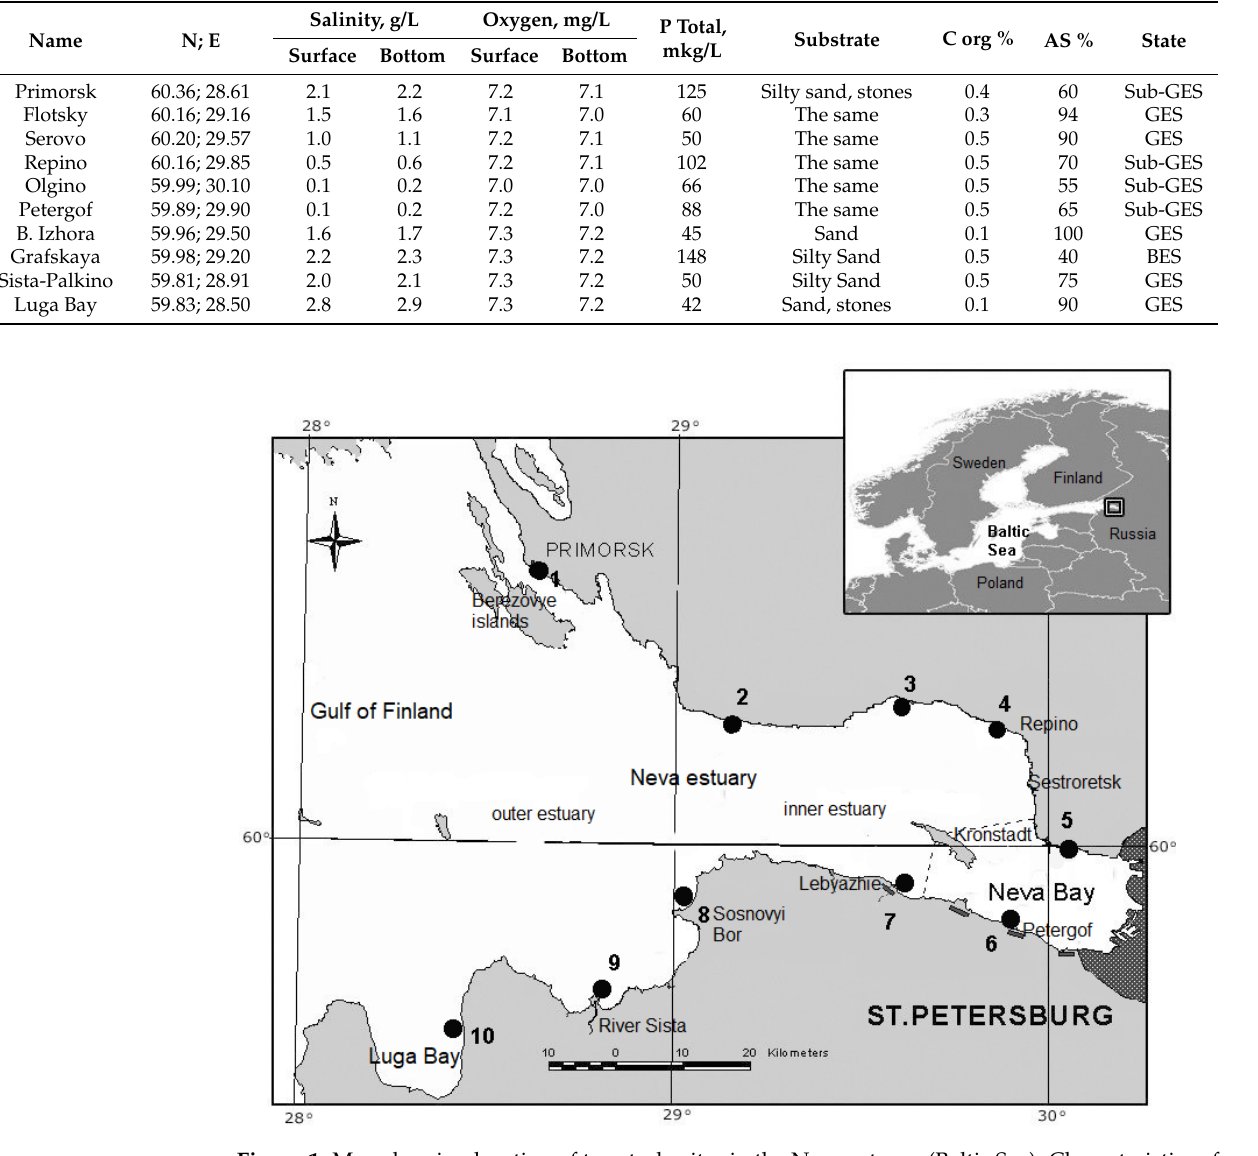
Figure 1. Map showing location of ten study sites in the Neva estuary (Baltic Sea). Characteristics of these sites are given in Table 1. Table 1. Study sites’ l ocation, physical, and chemical characteristics. P is phosphorus and C is carbon in sediment, AS is amphipod survival, GES and BES mean good and bad environmental state.